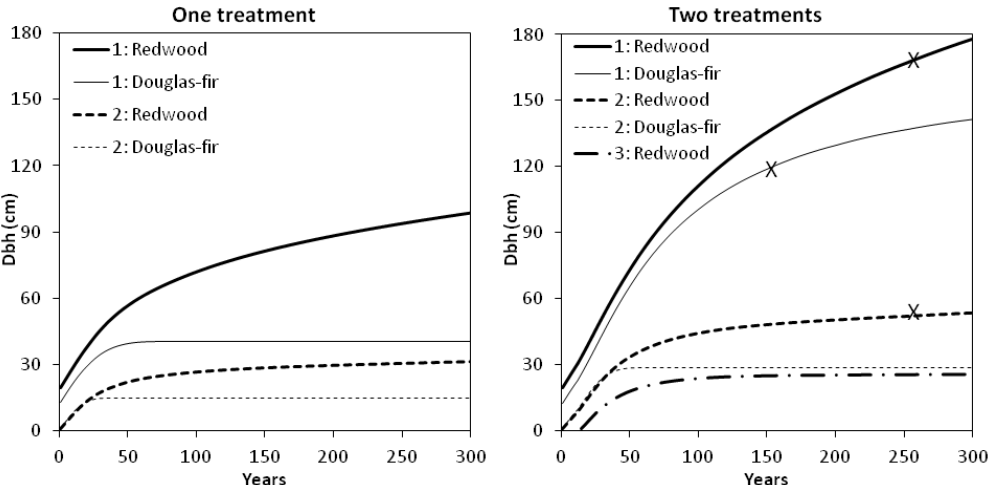
Figure 5. Simulated diameter development of redwood and Douglas-fir in two or three cohorts (overstory cohort, “ 1 ”; second cohort, “ 2 ”; third cohort, “ 3 ”) under two different scenarios. Left panel: “One treatment” with 465 overstory stems ha −1 remaining after one precommercial thinning (PCT) (before time zero). Right panel: “Two treatments” including one PCT (before time zero) followed by a second stand entry (partial cutting to leave 70 stems ha −1 in the overstory) before the average overstory redwood reached 30 cm dbh. Restoration goals for mean dbh denoted by